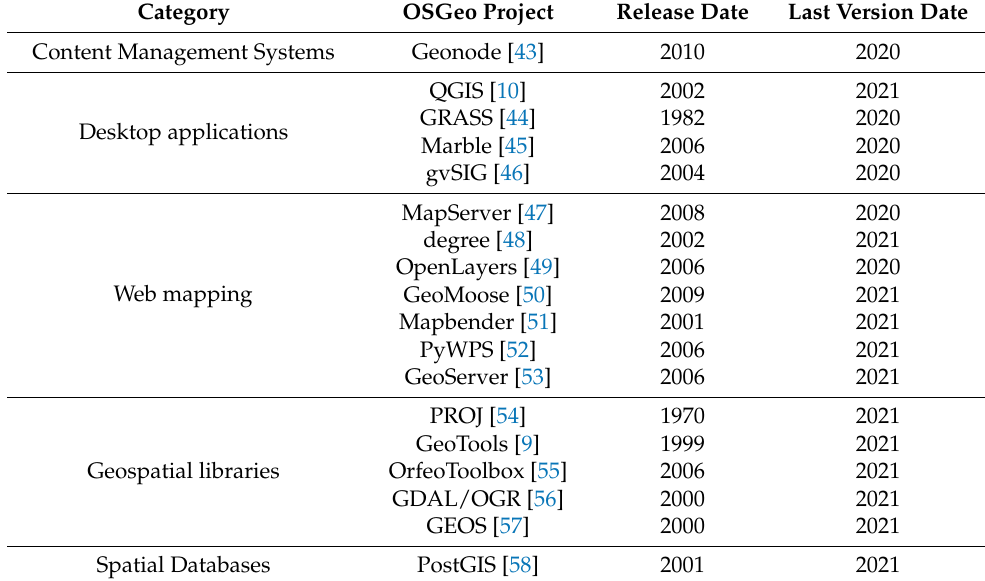
Table 1. OSGeo projects (release and last versions